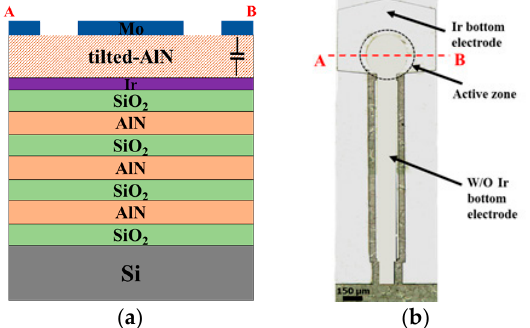
Figure 1. SMR structure ( a ) AB cross section scheme of the device active area; ( b ) Optical image of the device top view where electrical extensions can be